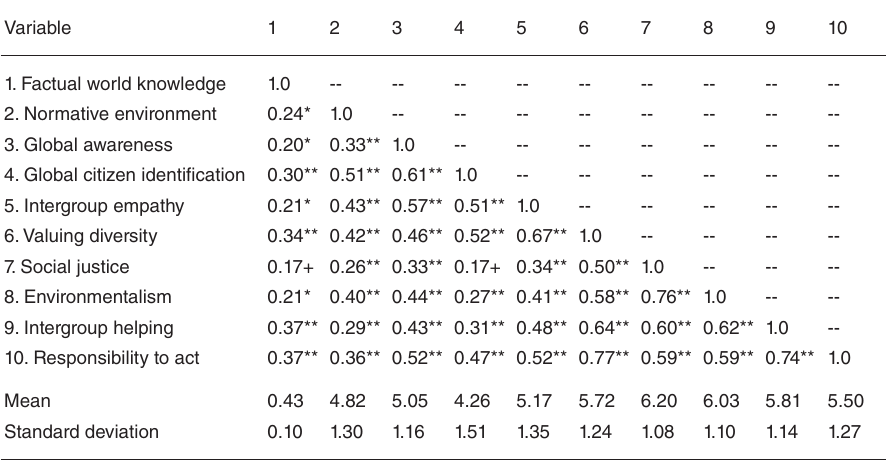
Table 1: Correlations between assessed variables, Study